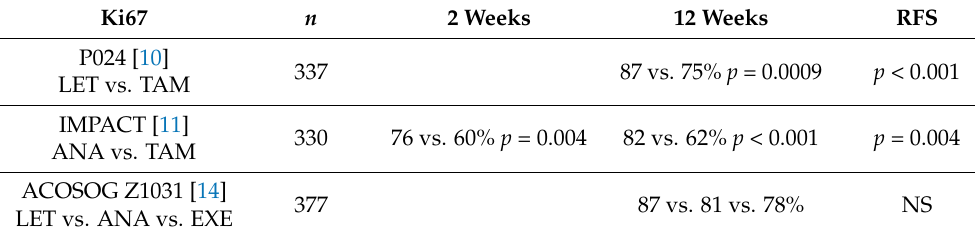
Table 4. Comparison of reductions in Ki67 expression levels with different NET at various time-points and correlation with